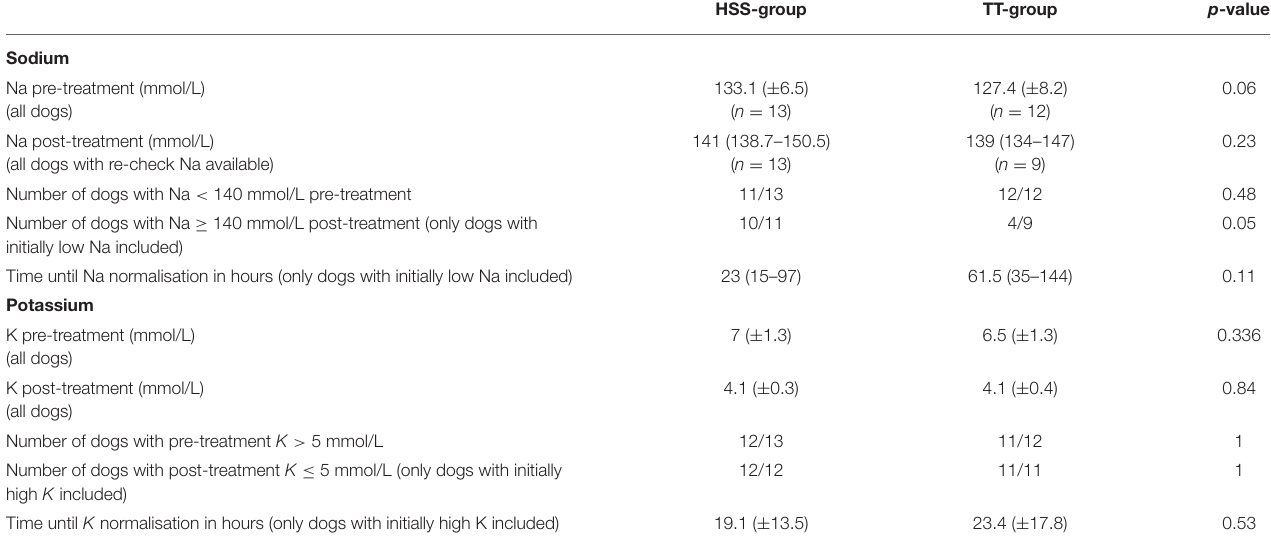
TABLE 3 | Comparison of pre- and post-treatment sodium and potassium concentration as well as time until concentration normalisation of these two electrolytes between dogs treated with hydrocortisone CRI (HSS group; n = 13) and dogs treated with prednisolone/dexamethasone (TT group; n = 12).